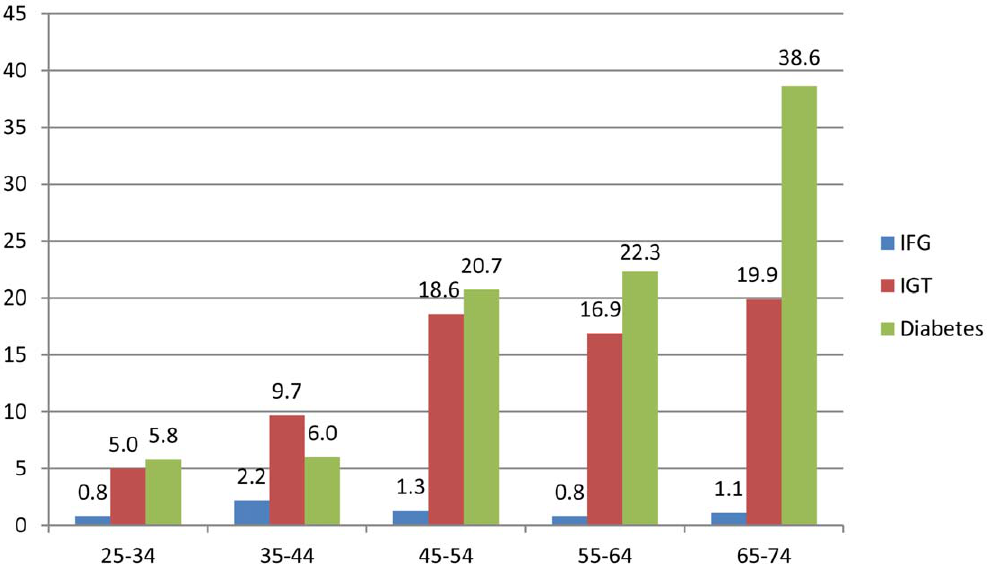
Figure 1. Prevalence of glycaemic categories based on 1998 WHO criteria presented by age categories. Footnote: IFG: impaired fasting glycaemia; IGT: impaired glucose tolerance.